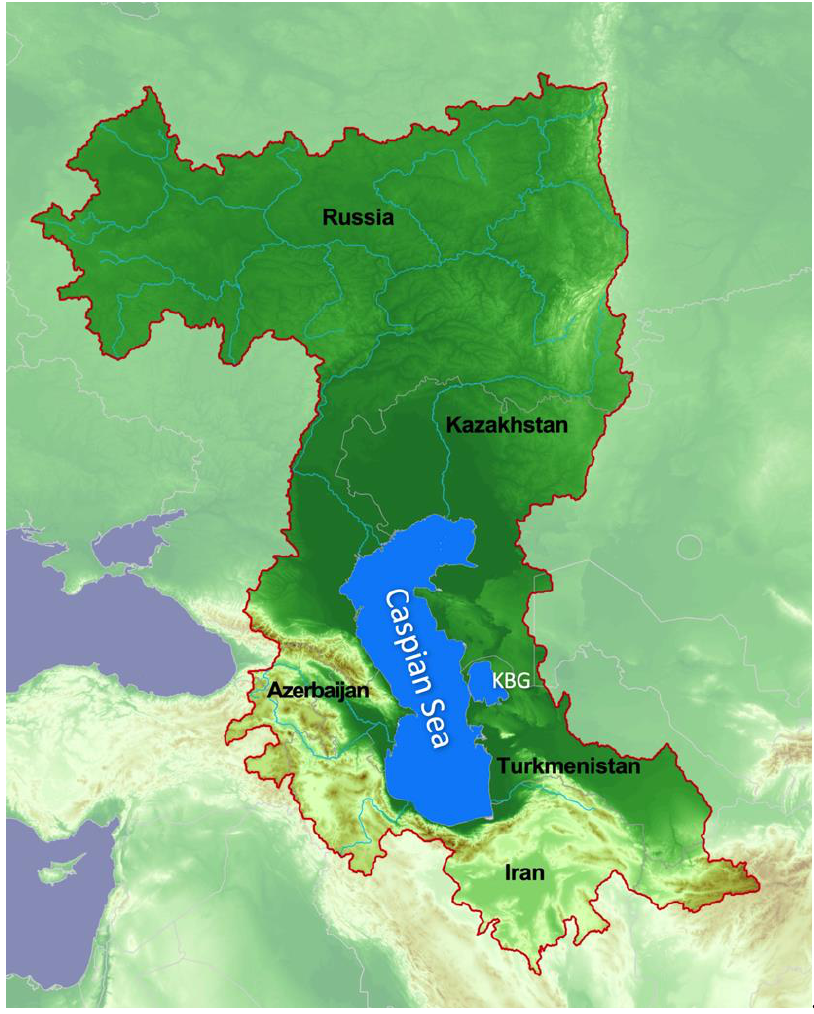
Figure 1. The Caspian Sea and the Caspian Sea drainage basin (circled by the red boundary curves), with five surrounding countries (Russia, Azerbaijan, Iran, Turkmenistan, and Kazakhstan) labeled. Accurate measurements of CSL change play a critical role in understanding CSL variability at different temporal scales and connections with driving forces in the global and regional climate system and predicting future CSL change and potential impacts on the ecosystem in the Caspian Sea region. Tide gauge observations are also important for monitoring CSL change, especially at long-term time scales (from multi-decadal to a hundred years). However, due to special data policies in the surrounding countries, most (if not all) tide gauge observations along the Caspian Sea coasts are not available to the general public. Other challenges in using and interpreting tide gauge observations include the inconsistent temporal coverages, data qualities, and vertical land movements of the tide gauge stations. Satellite remote sensing has become an advanced observational tool to monitor the global ocean since the late 70s. Satellite-borne Synthetic Aperture Radar technique has been used since 1978 for sea surface monitoring, as well as for mapping applications [7–9]. Satellite radar altimeter experiments were also started at about the same time, with the accuracies of the early altimeter sea level observations at only meter level, inadequate for meaningful sea level change